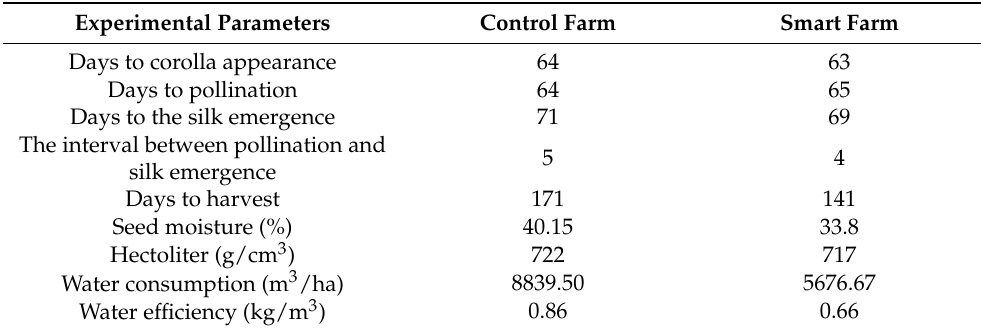
Table 2. Different experimental factors under the influence of different forms of irrigation manage- ment in the control and smart fields (based on whole field harvest or estimation). Experimental Parameters